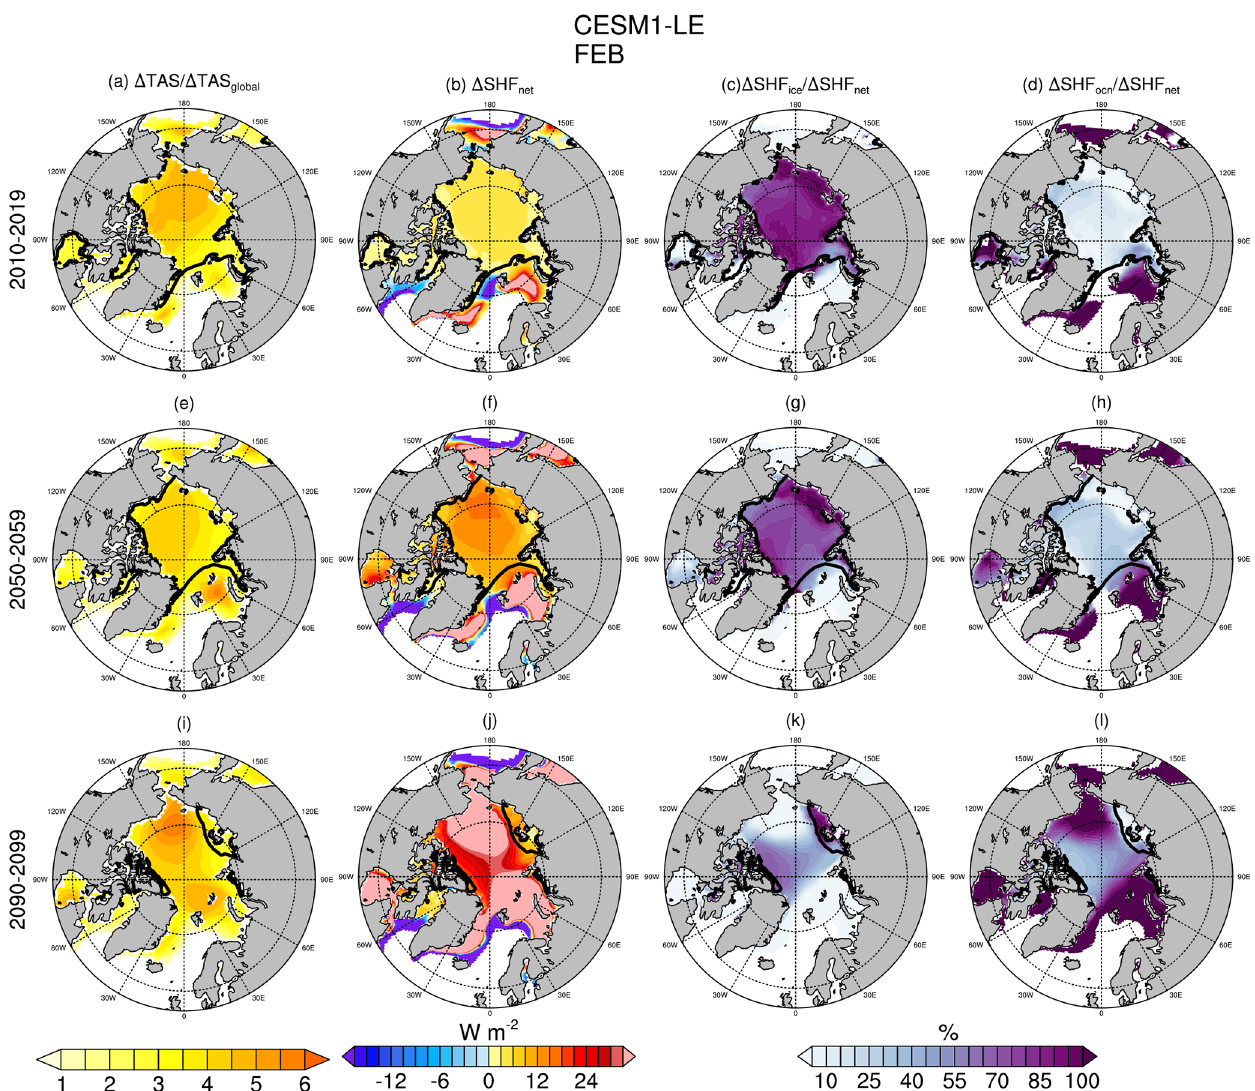
Figure 4. February decadal mean changes (1950–1959) in Arctic amplification ( (cid:49) TAS/ (cid:49) TAS global , where TAS is the near-surface air temperature; a, e, i ), net surface heat fluxes (b, f, j) , sea ice contribution to surface heat fluxes (c, g, k) , and ocean contributions to surface heat fluxes (SHFs) (d, h, l) for the 2010s (a, b, c, d) , the 2050s (e, f, g, h) , and the 2090s (i, j, k, l) . The 98% SIC for each decade is shown by the thick black